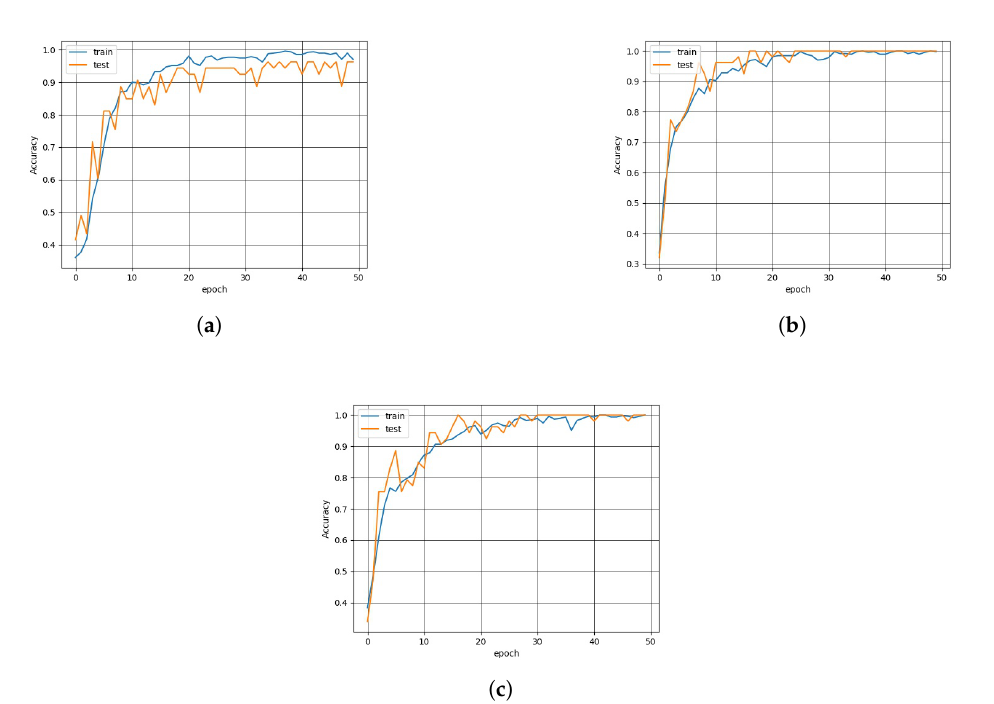
Figure 11. Classification accuracy among four different walking patterns. ( a ) Micro-Doppler signatures-based classification accuracy; ( b ) interferometric signatures-based classification accu- racy; ( c ) dual micro-motion signatures-based classification accuracy.